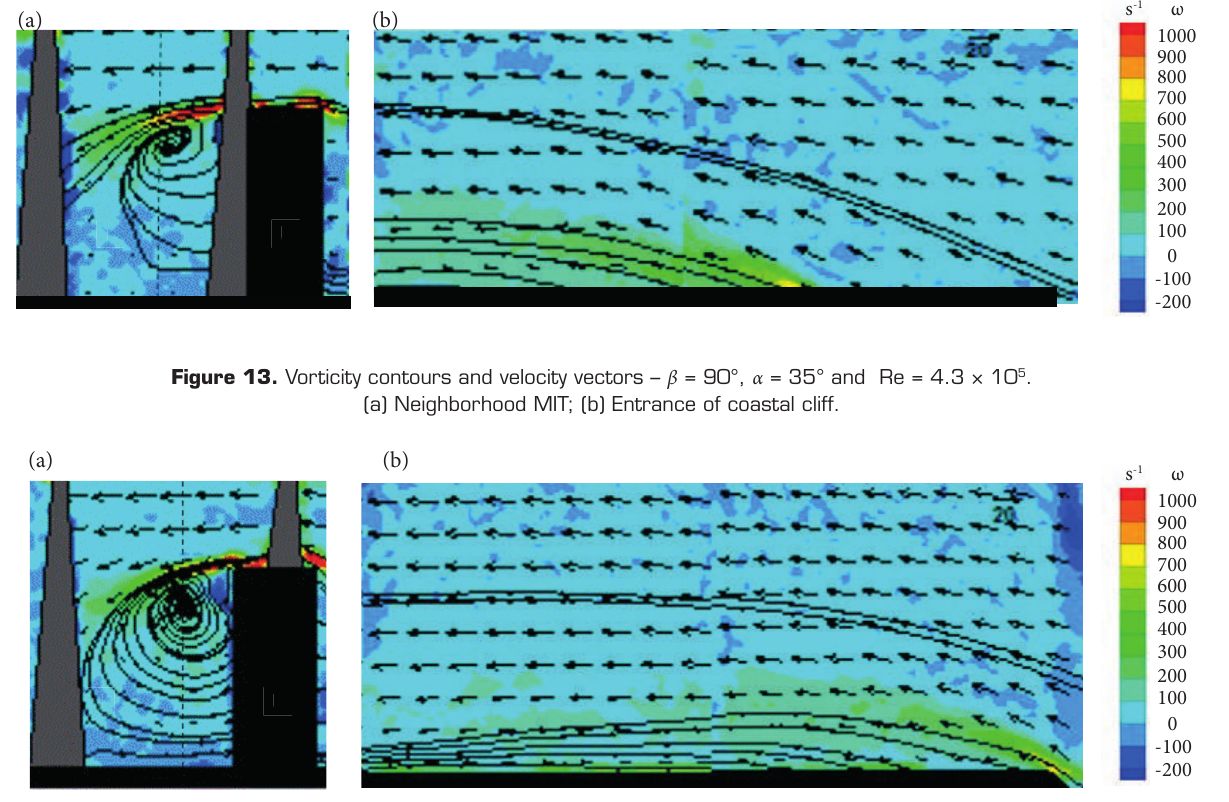
Figure 14. Vorticity contours and velocity vectors – β = 90°, α = 45° and Re = 4.3 × 10 5 .